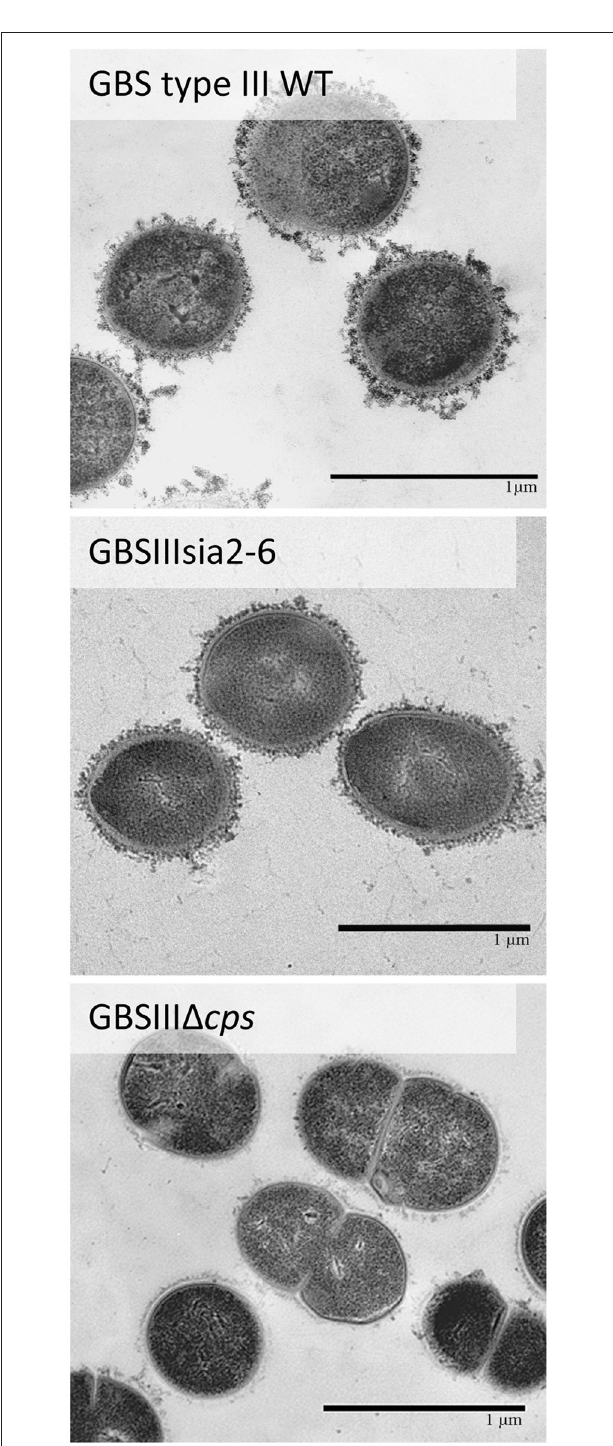
FIGURE 11 | Transmission electron micrographs showing capsular polysaccharide (CPS) expression by GBS type III mutant carrying exogenous α -2,6-sialyltransferase. The CPS was labeled with polycationic ferritin. GBS type III wild-type strain was surrounded by a consistent CPS layer, whereas the GBSIIIsia2,6 ( 1 cps3K / cps2N ) mutant showed intermediate state of encapsulation. The non-encapsulated strain GBSIII 1 cps is depicted as negative control. Bars = 1 µ